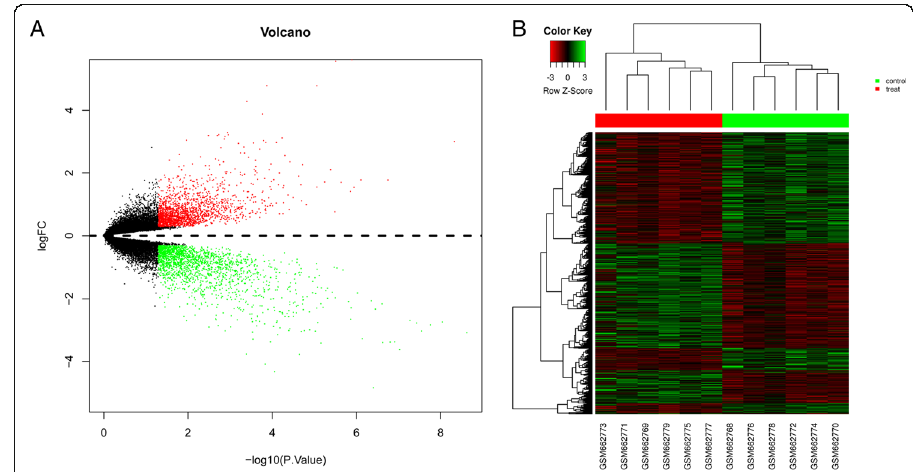
Fig. 1 Heat map and volcano plot for differentially expressed genes (DEGs) in breast cancer stroma cells compared with normal breast stroma from GSE26910. a – Volcano plot of DEGs in breast cancer stroma cells from GSE26910. x-axis: LogFC, large magnitude fold changes; y-axis: -log10 of p -value, high statistical significance. Red and green points: log 2 |fold change| ≥ 1 and p value <0.05. Black points: log 2 |fold change| <1 or p value >0.05. b – Dendrogram of DEGs identified via cluster analysis. Each column represents one sample. The green header indicates normal stromal cells and red indicates breast cancer stromal cells. Each row represents one gene, with red representing high relative expression, and green representing low relative expression